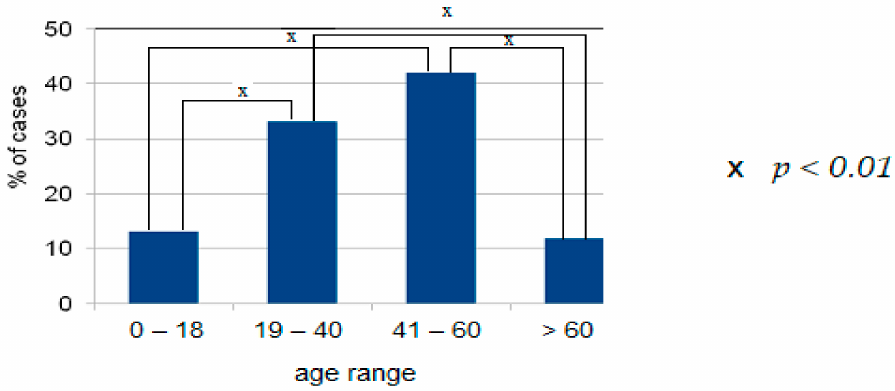
Figure 1. Distribution of patients by age range in the analyzed